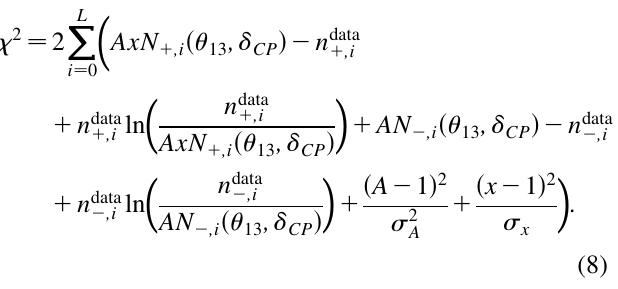
Similarly, measurements at the near detector combined with muon decay rate measurements from instrumentation in the muon decay ring should reduce the uncertainty (cid:7) A to below 1% [13]. Conservative upper limits for these errors of 3% and 2.5% respectively are also considered in this study, but the neutrino factory will allow much better control of these systematic uncertainties. The (cid:6) 2 contours defined by a series of fits with different values of CP violating phase are shown in Fig. 11. The error of a measurement of the CP violating phase is determined by finding the width of the contour defined ¼ 9 : 0 (cid:5) . A neutrino factory offers the best by (cid:6) 2 ¼ 1 at (cid:1) 13 prospect to improve the precision of the measurement of (cid:1) . The uncertainty curves for (cid:2) CP derived from simu- 13 lations using the (cid:4) þ and (cid:4) (cid:1) focusing fields are shown in Fig. 12. Uncertainty curves are identical for the two cases, suggesting that the variation in the momentum response resulting from the change in the detector field properties averages out when the species are added together for the (cid:6) 2 calculation.